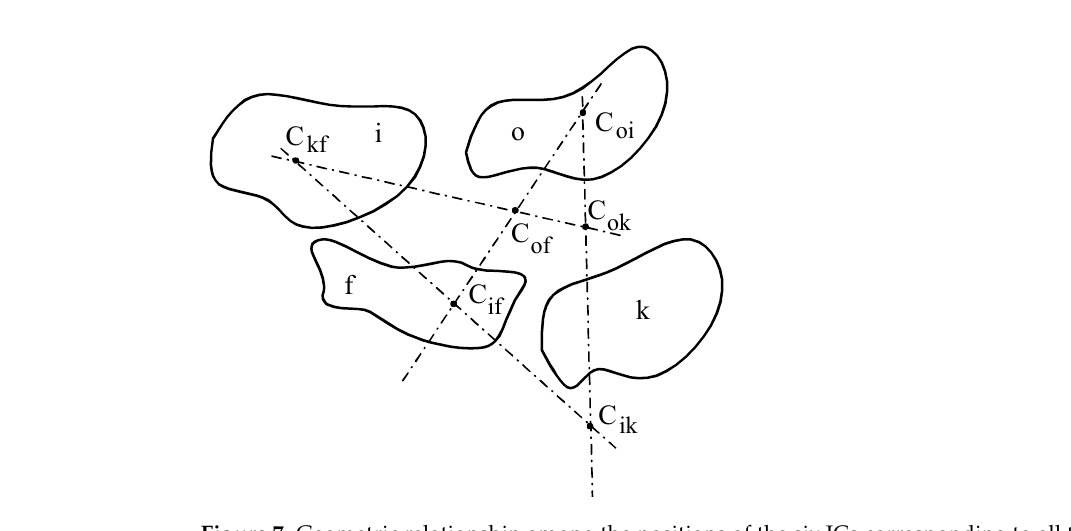
Figure 7. Geometric relationship among the positions of the six ICs corresponding to all the possible relative motions among the links i, o, f, and k. Table 1. Analytic expressions of the coefficients a and b appearing in the I/O instantaneous relation- ships (Equation (6)) of single-DOF PMs deduced in [31] ( C mn ( t mn ) with mn ∈ {if, ok, ik, kf, oi, of} is the complex number that gives the IC position (the unit vector of the positive-translation direction (Figure 3b) of the relative motion of link m with respect to link n).